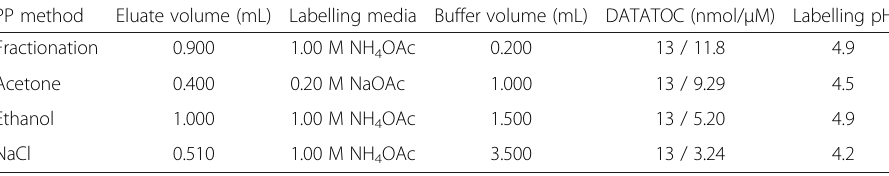
Table 1 Key features of the radiolabelling procedures used PP